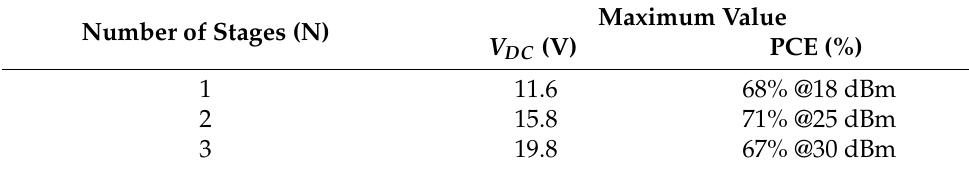
Table 2. Performance summary of the measured N-stage HTVM.